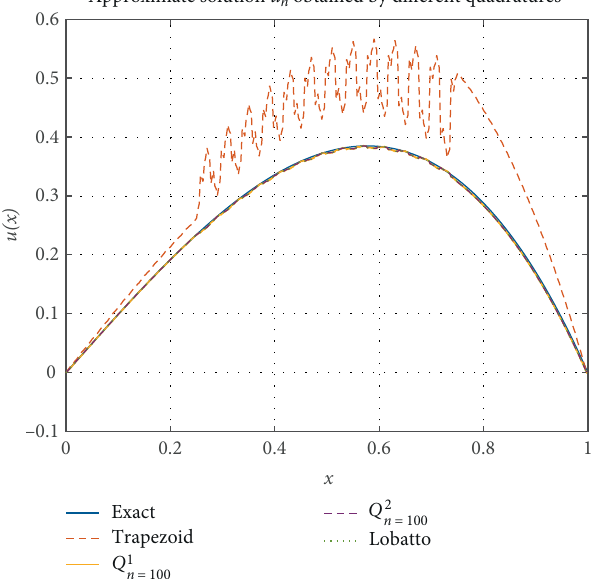
Figure 5: Exact solution 0.002501. ℎ =